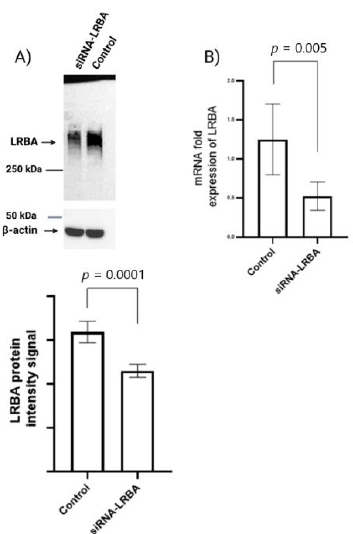
Figure 4. siRNA-mediated knockdown of LRBA. MIN6 cells were transfected for 72 h with siRNA targeting LRBA. ( A ) The Western blot shows successful knockdown of LRBA (at ≈ 319 kDa). Β -actin was used as a loading control (at ≈ 43 kDa). ( B ) qRT-PCR quantification of LRBA mRNA in MIN6 cells after 72 h of transfection yielded a knockdown efficiency of ≈60%, respectively. Error bars represent SEM of three independent experiments.